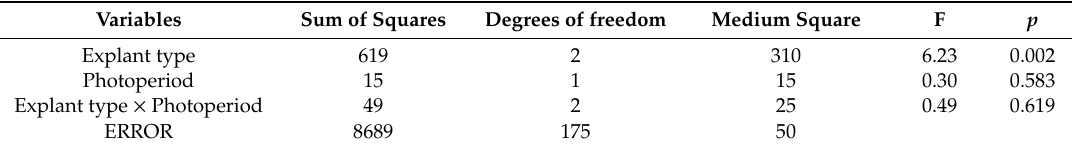
Table 1. Variance analysis summary for callogenesis rates during induction, as a ff ected by the